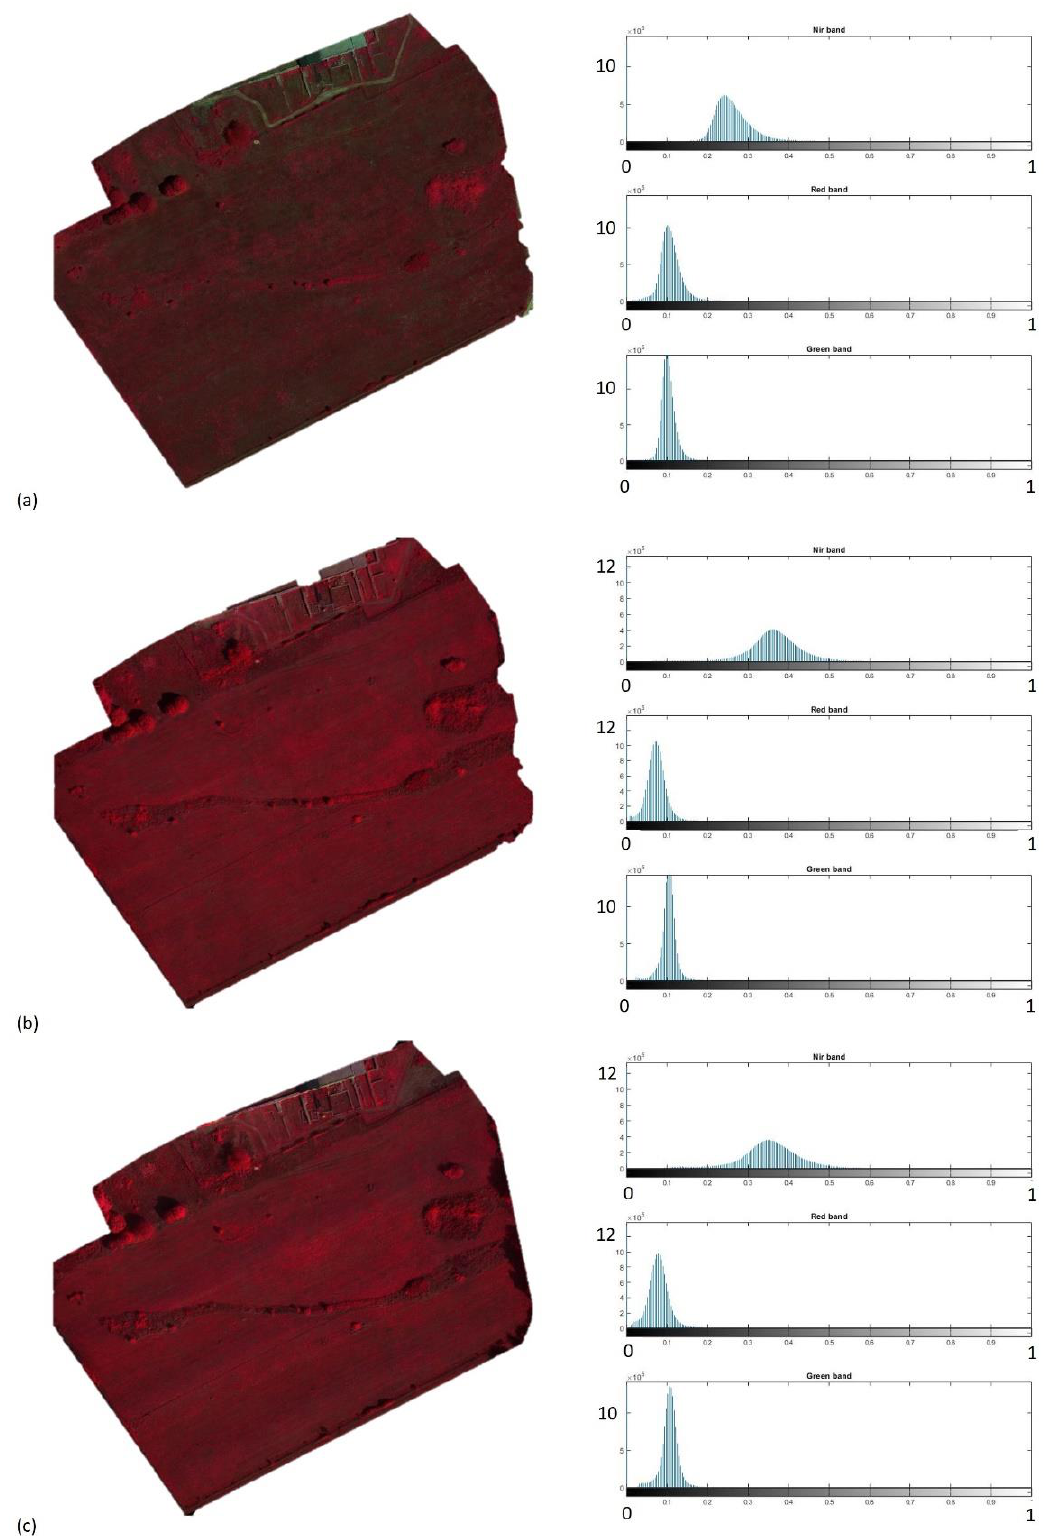
Figure 6. FCIR composite and single band histogram: ( a ) July, ( b ) August, and ( c ) September. Histogram techniques can be applied on gray-level images, single channel, images or on RGB (multichannel) images, completely changing the rendering of the final result com- pared to the initial one [66]. According to Lasaponara and Masini [63,64], radiometric en- hancement techniques used were (i) minimum–maximum and percentage linear contrast stretch (linear technique), (ii) histogram equalisation (nonlinear techniques). Both tech- niques were applied with the aim to increase the contrast and improve the identification of features of archaeological interest and select them from the background (see Section